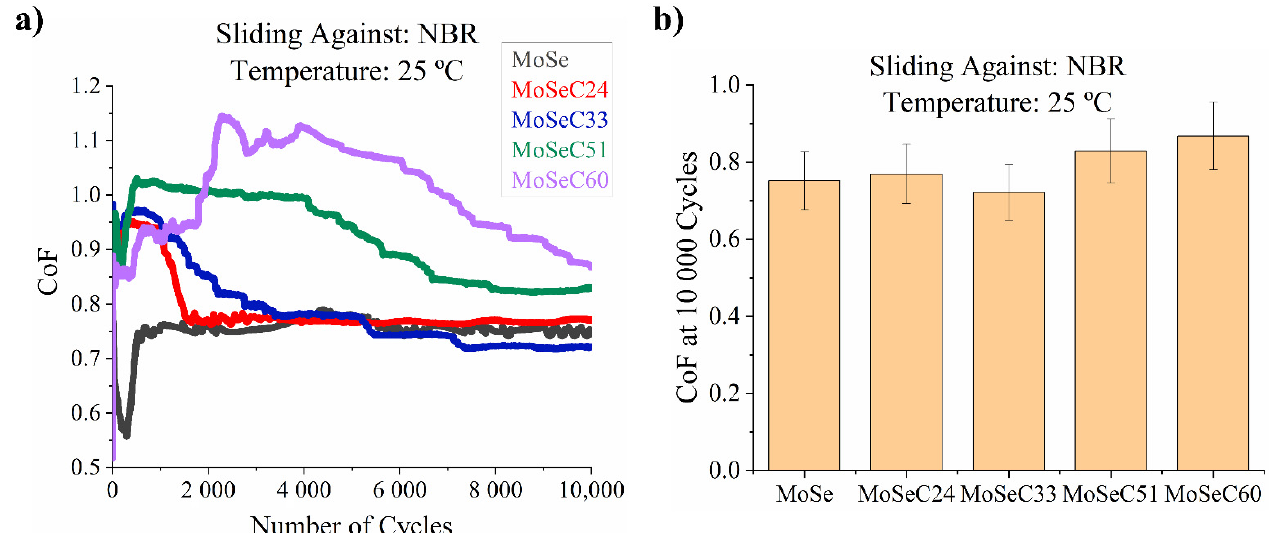
Figure 9. Results of the POD tests, performed against a nitrile butadiene rubber (NBR) countersurface, at 25 °C: ( a ) friction curves; ( b ) final CoF.